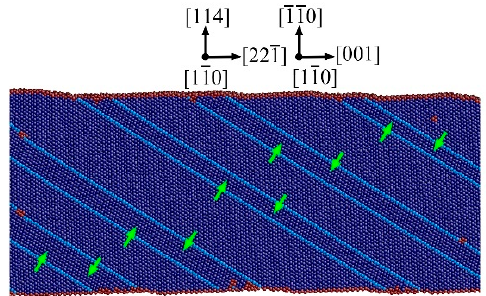
Figure 10. Twin migration of the NT Au nanowire with θ = 54.74° and λ = 2.83 nm at the strain of 0.12. The atoms are colored according to the CNA. The green arrows denote the direction of CTBs migration.